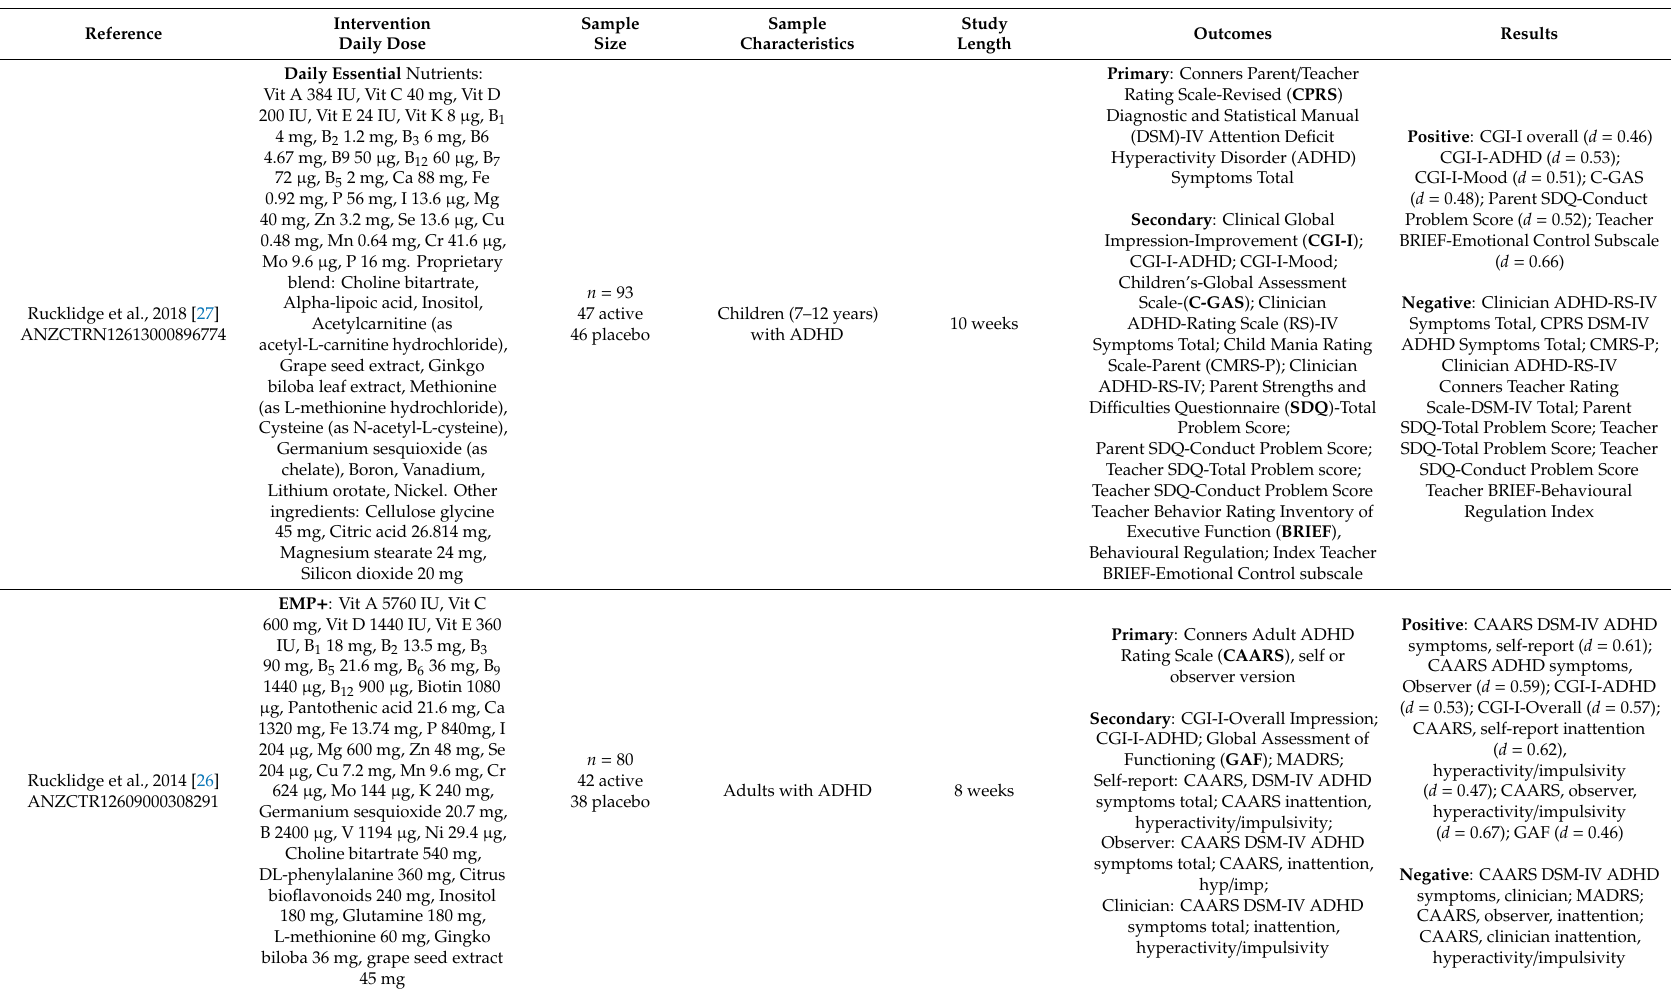
Table 6. ADHD studies ( n =